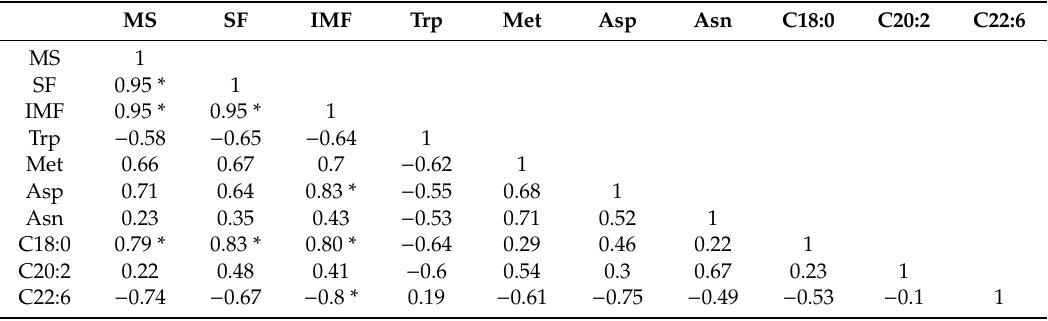
Table 5. Correlation analysis of the indexes of longissimus dorsi in Liangshan pig.